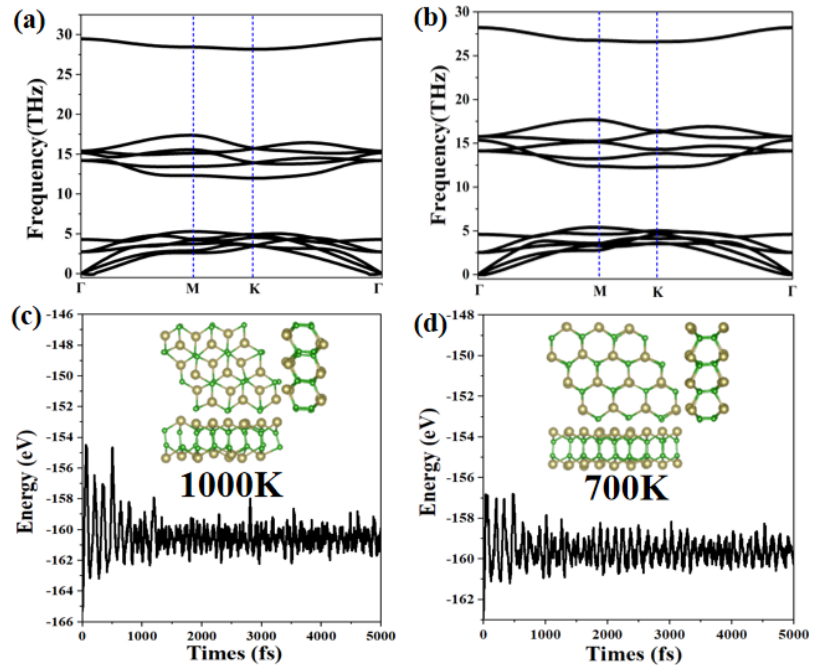
Figure 2. The calculated phonon spectrum for the α -TeB ( a ) and β -TeB ( b ) monolayers, respectively. The energy fluctuation and the corresponding structure during the AIMD simulations at 1000 K for α -TeB ( c ) and 700 K for β -TeB ( d ).